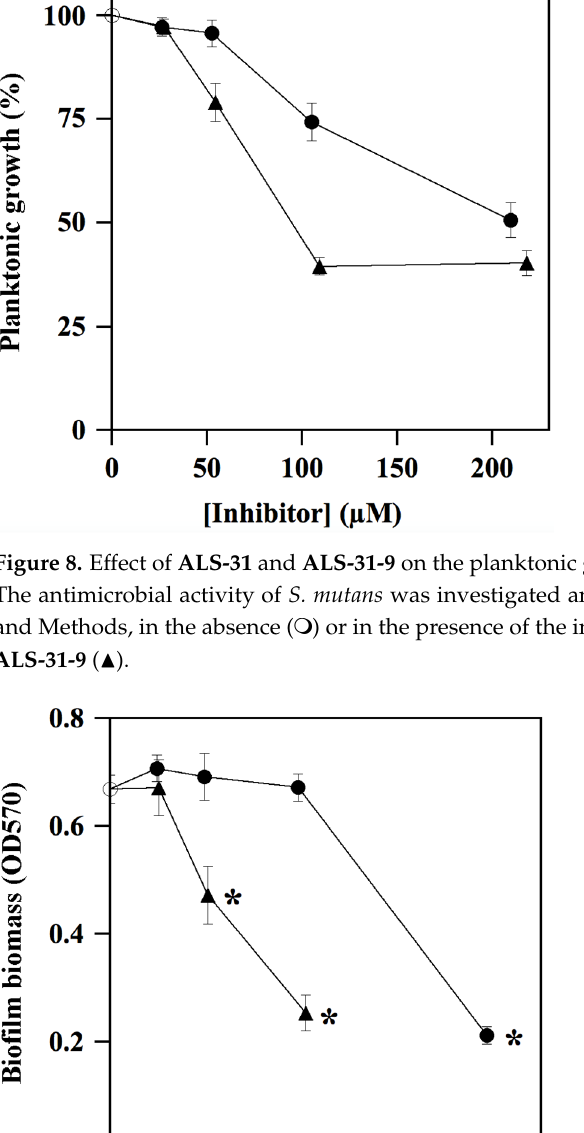
Figure 9. Effect of ALS-31 and ALS-31-9 on the antibiofilm activity of Streptococcus mutans cultures. Figure 3. Effect of ALS-31 or ALS-19 on the activity of Sm SOD. The SOD activity was measured in triplicate, as indicated in the Materials and Methods, and reported as the mean ± SE. Values of re- sidual activity were expressed as a percentage of the activity measured in the absence ( ) or in the presence of the indicated concentration of ALS-31 ( ) or ALS-19 (